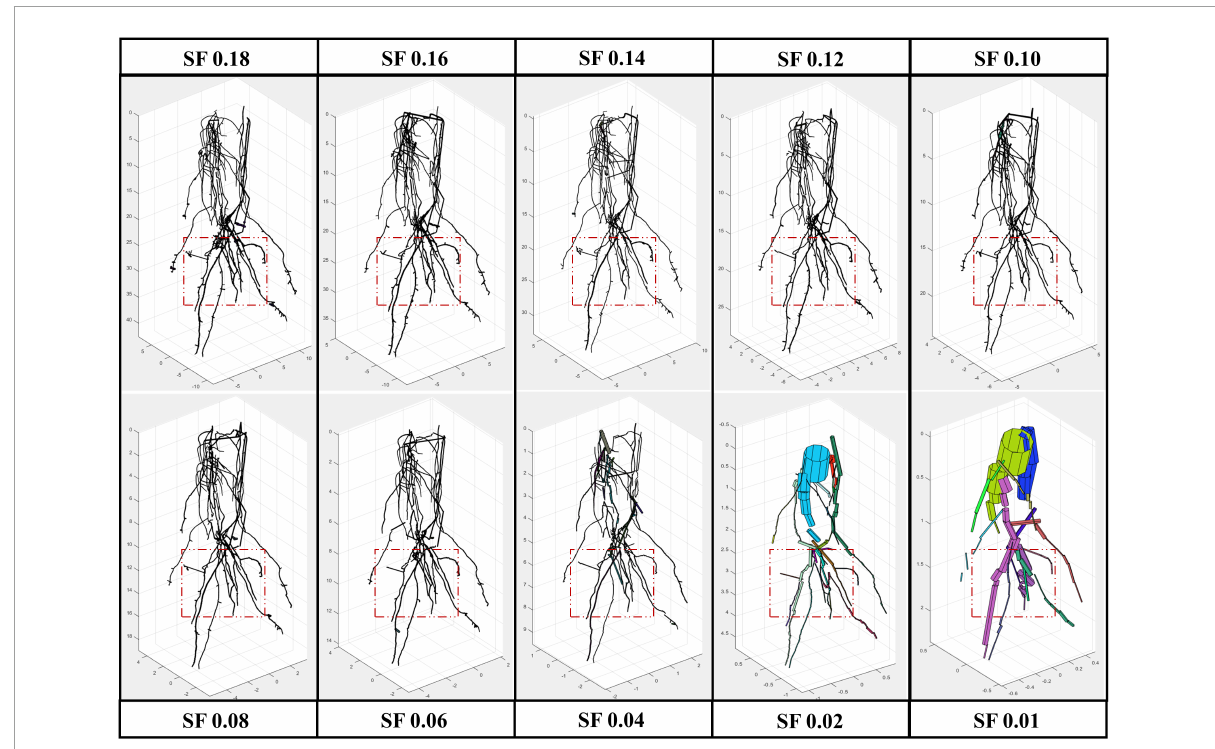
FIGURE2 Root model results from the same scan using several scale factor (SF) values, from 0.01 to 0.18 with a remarked window in red where zoom is provided ( Figure 3 ).